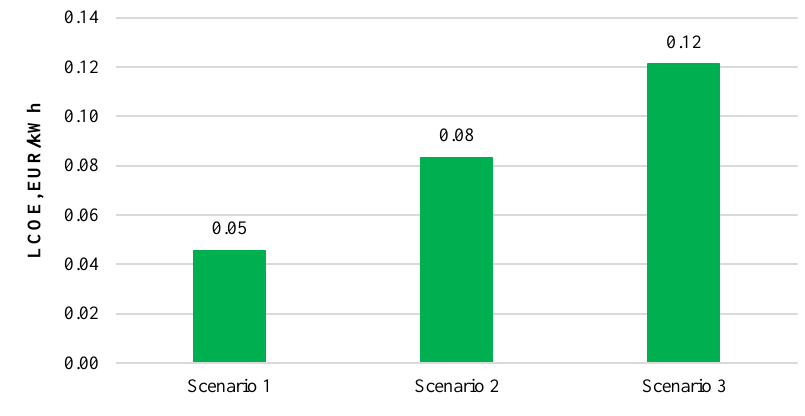
Fig. 5. Weighted average electricity price (LCOE) for woodchip cogeneration with a capacity of 7 MW. Calculated Levelized Cost of Electricity is displayed in Fig. 5.